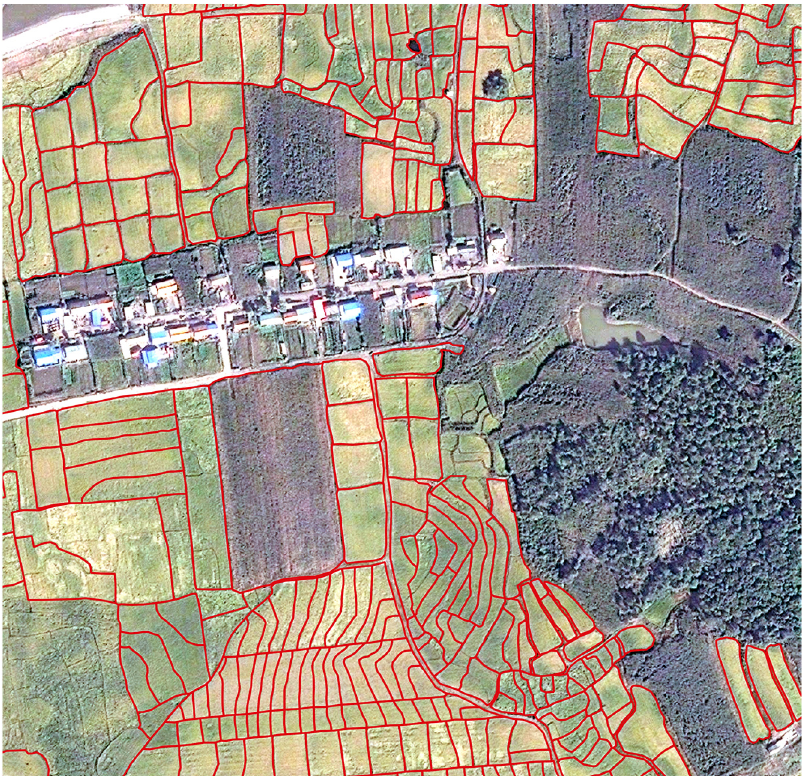
Figure 3. A portion of field boundary annotation on the fine-resolution satellite image (0.5 m spatial resolution).